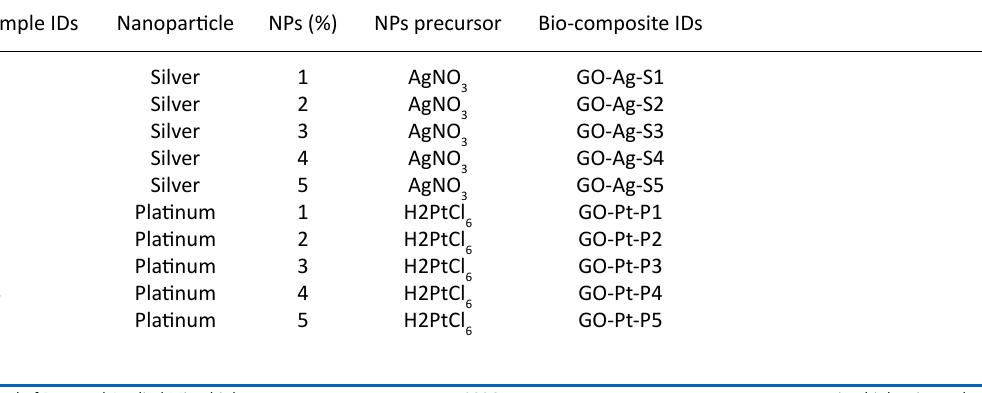
Table 1. Sample IDs of newly in-house engineered silver and platinum nanoparticles loaded graphene-based